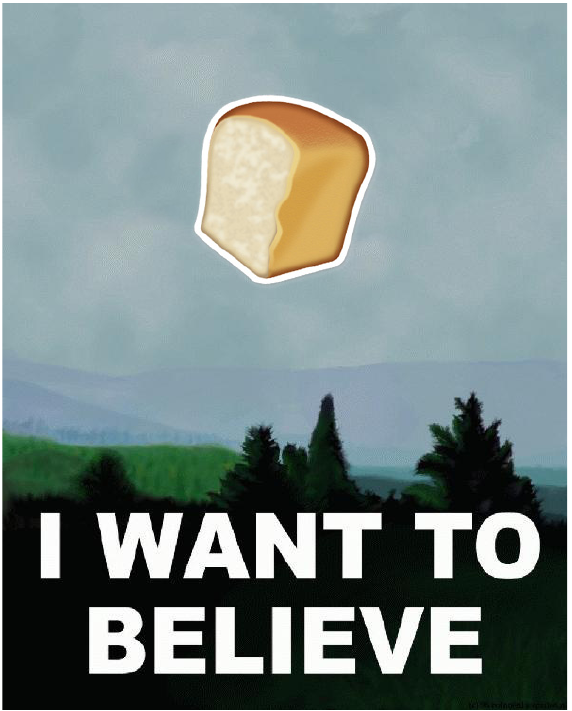
Figure 1. Fanart posted to the “Baby Nation” facebook fan group, the same day that “Bread Theory” was introduced on the podcast.